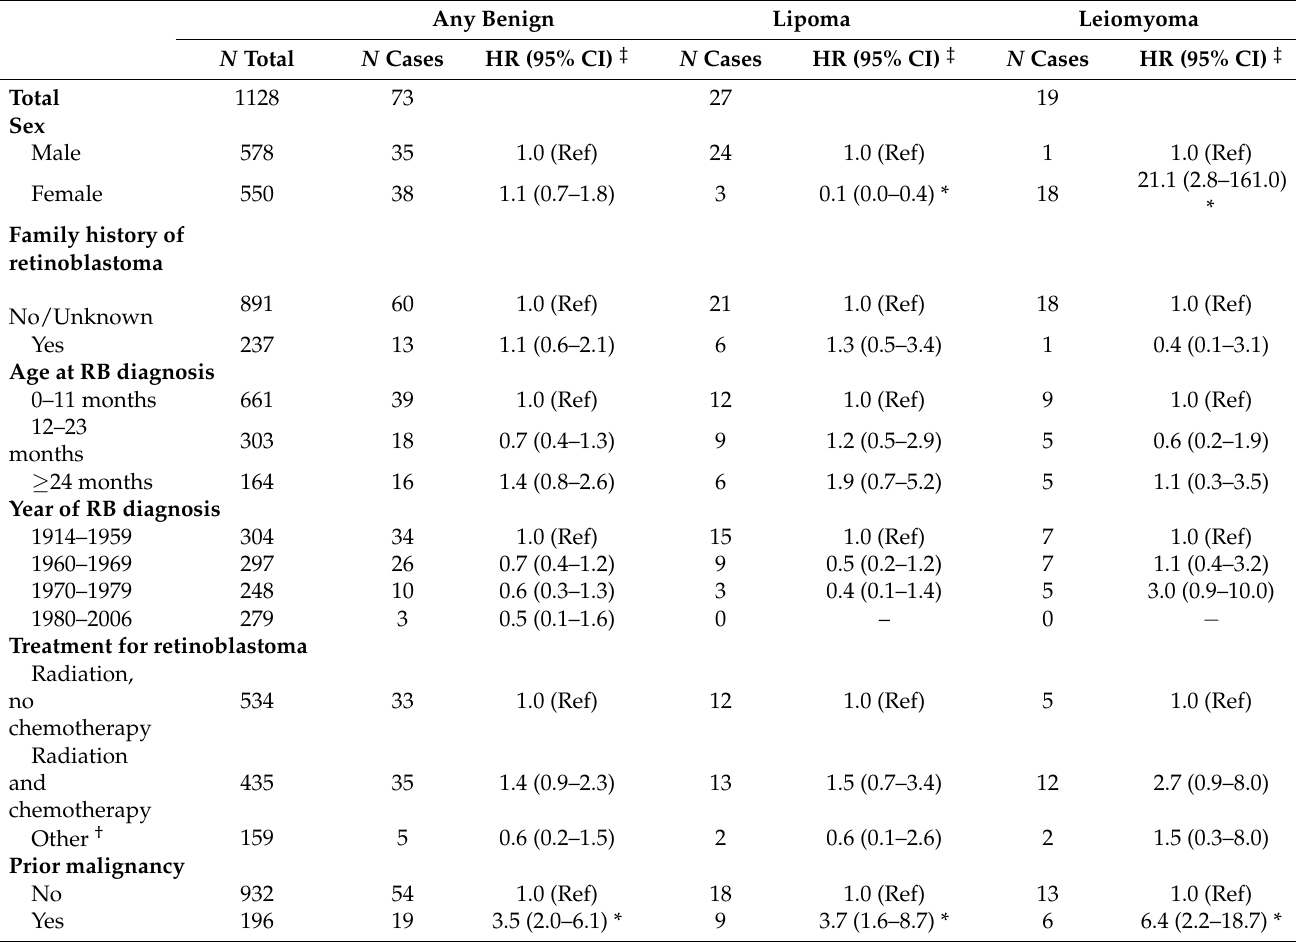
Table 3. Risk factors for benign tumors among 1128 hereditary retinoblastoma survivors. Any Benign Lipoma